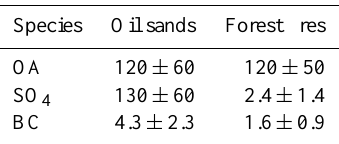
Table 3. Aerosol enhancement ratios relative to CO. Units are mgaerosol ( gCO ) − 1 . Forest fire data are from fresh plumes ob- served during ARCTAS (Singh et al.,